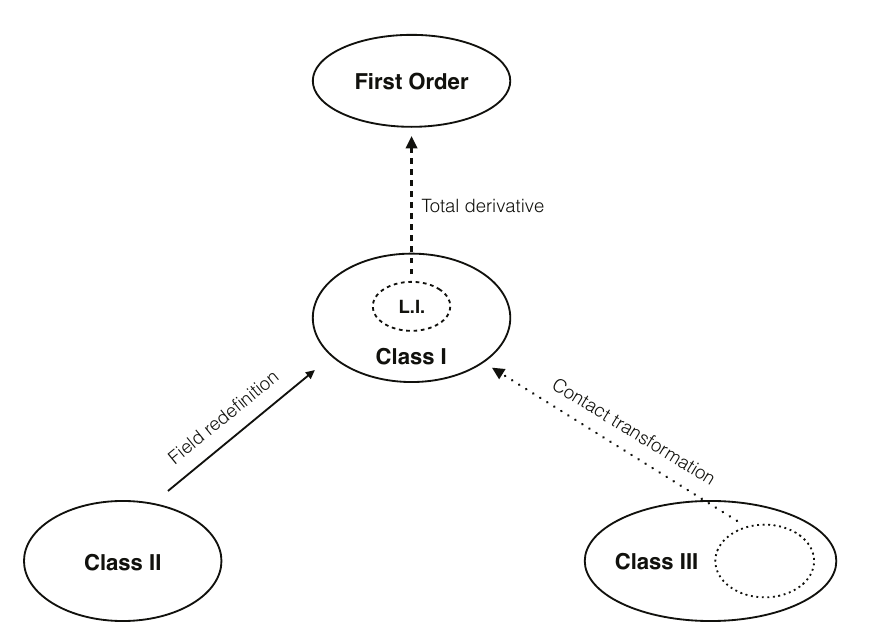
Figure 1 . Schematic representation of the three di(cid:11)erent classes of theories and their connections. Class II theories can always be put in Class I form via (cid:12)eld rede(cid:12)nitions. Only a very small subset of theories in Class III can be brought to Class I with extended contact transformations. Finally, Lorentz invariant theories in Class I can be reduced to standard, (cid:12)rst order form by adding a total